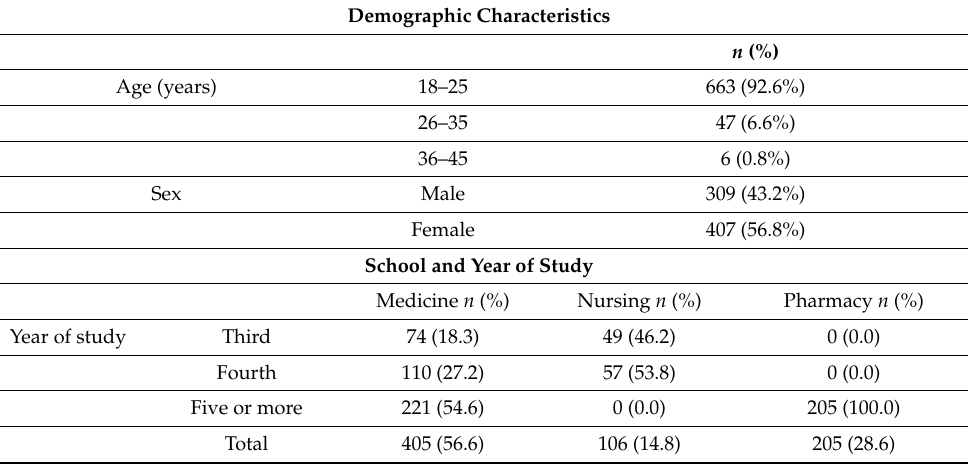
Table 1. Demographic characteristics of medical, nursing and pharmacy students ( n = 716).